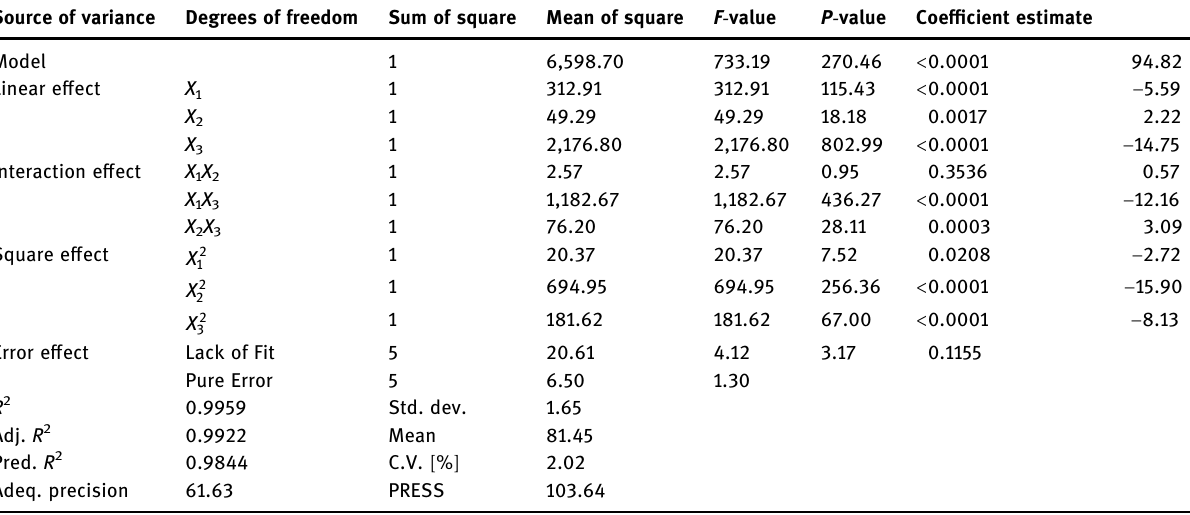
Table 4: Analysis of variance for biosorption of Ni 2 + ions by Gelidium amansii biomass from aqueous solution obtained by FCCCD Source of variance